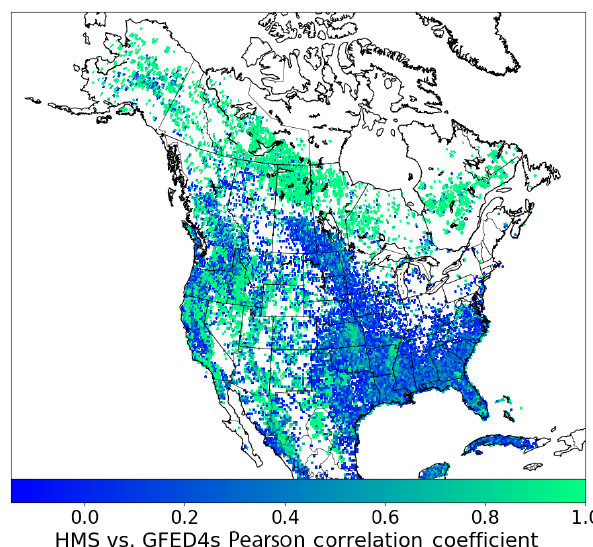
Figure 5. Plan view monthly time series Pearson correlation coef- ficient for monthly HMS-hours and GFED4s kilograms of carbon for each 0.25 × 0.25 ◦ grid cell. White grid cells are locations where one or both of the inventories have zero emissions for all 96